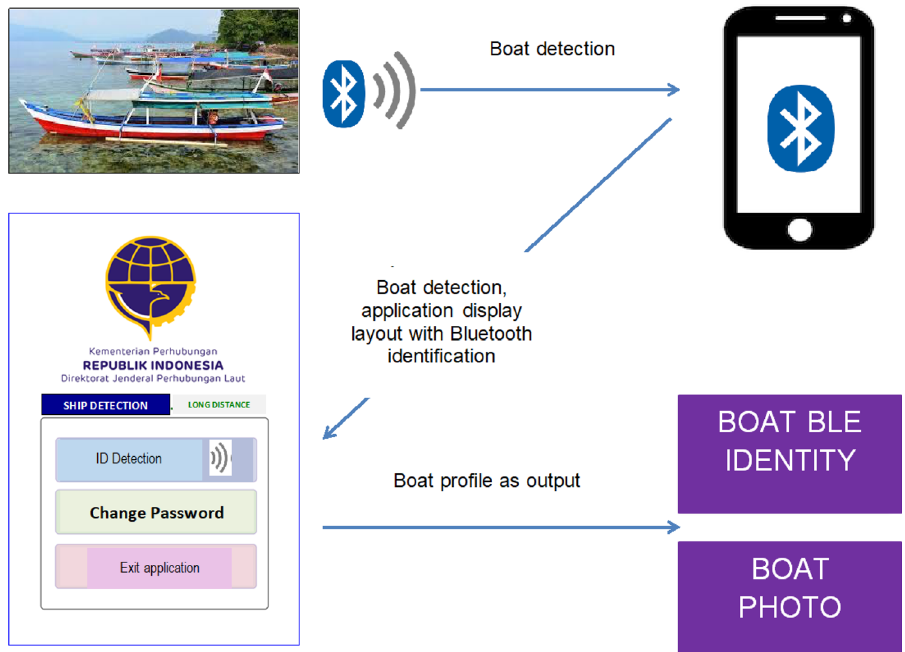
Fig. 6 boat identification application design connecting BLE sensors to computer and